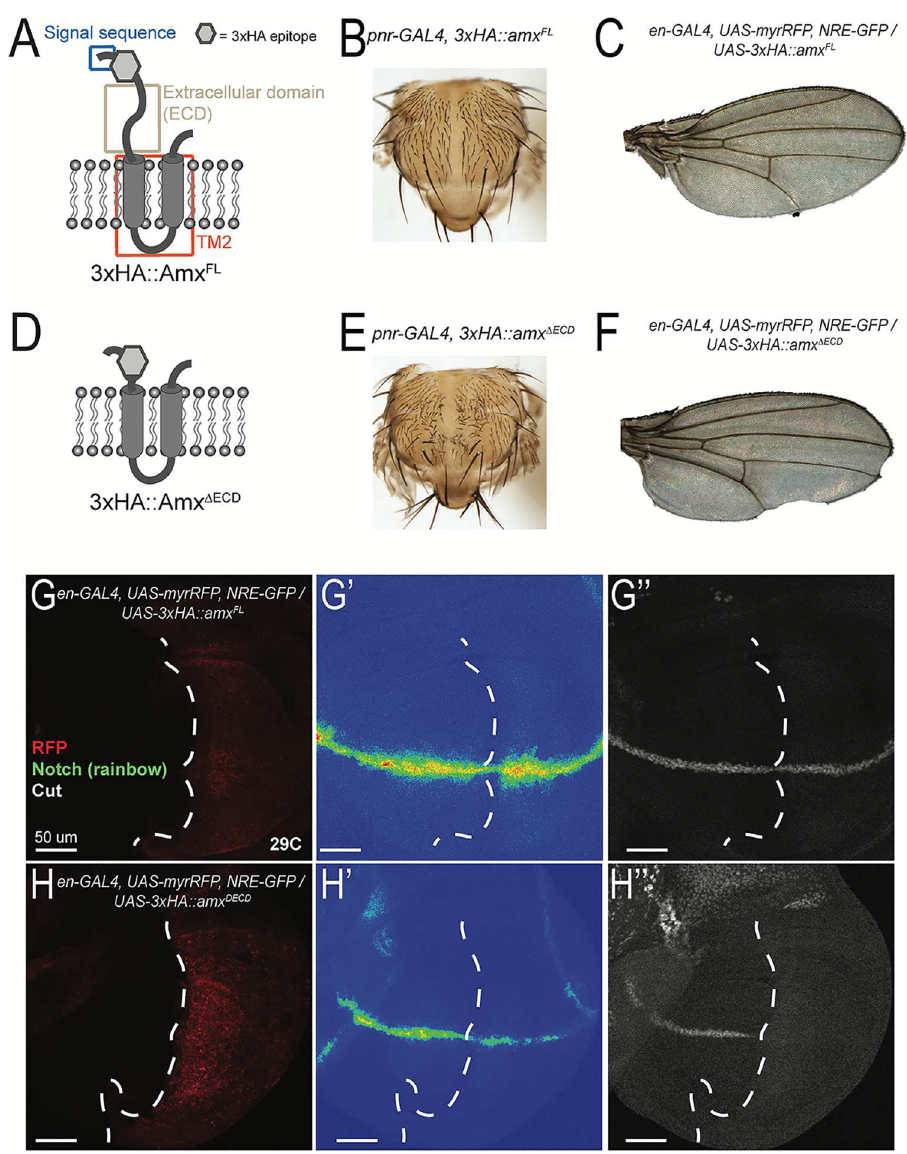
Fig 4. Amx that only possesses the highly conserved TM2 domain is a potent inhibitor of Notch signaling. (A, D) Schematic of proteins generated from UAS-3xHA :: amx FL and UAS-3xHA :: amx Δ ECD transgenes. A 3xHA epitope (grey hexagon) was inserted after a predicted signal sequence (SS, blue box). The majority of the extracellular domain (ECD, light brown box) was removed to generate 3xHA::amx Δ ECD , consisting mostly of the TM2 domain (red box) tagged with the N-terminal 3xHA epitope. (B) Overexpression of 3xHA::Amx FL with pannier(pnr) -GAL4 has no effect on notum morphology. The absence of bristles along the midline is due to a very mild dorsal closure defect caused by the pnr -GAL4 insertion. (C) Expression of 3xHA::Amx FL in the posterior wing using engrailed ( en )-GAL4 has no effect of the morphology of wings of adults raised at 29˚C. (E) pnr-GAL4 driven overexpression of truncated Amx causes an increase in the number of micro- and macrochaete, indicative of loss of Notch mediated lateral inhibition. (F) en- GAL4 driven overexpression of 3xHA::Amx Δ ECD causes notching of the posterior wing margin. (G-H) Immunostaining of wing imaginal discs expressing full-length or truncated 3xHA::Amx. (G) 3xHA::Amx FL expression in the posterior imaginal wing disc using en-GAL4 has no effect on NRE (Notch response element)-GFP expression, a synthetic in vivo Notch signaling reporter (G’, rainbow) and on Cut (G”, white) expression, a downstream target of Notch activation in this context. The domain expressing GAL4 is marked by RFP (red). (H) Expression of 3xHA:: Amx Δ ECD decreases NRE-GFP (rainbow) expression (H’) and reduces Cut expression (H”). Scale bars = 50 μ m in